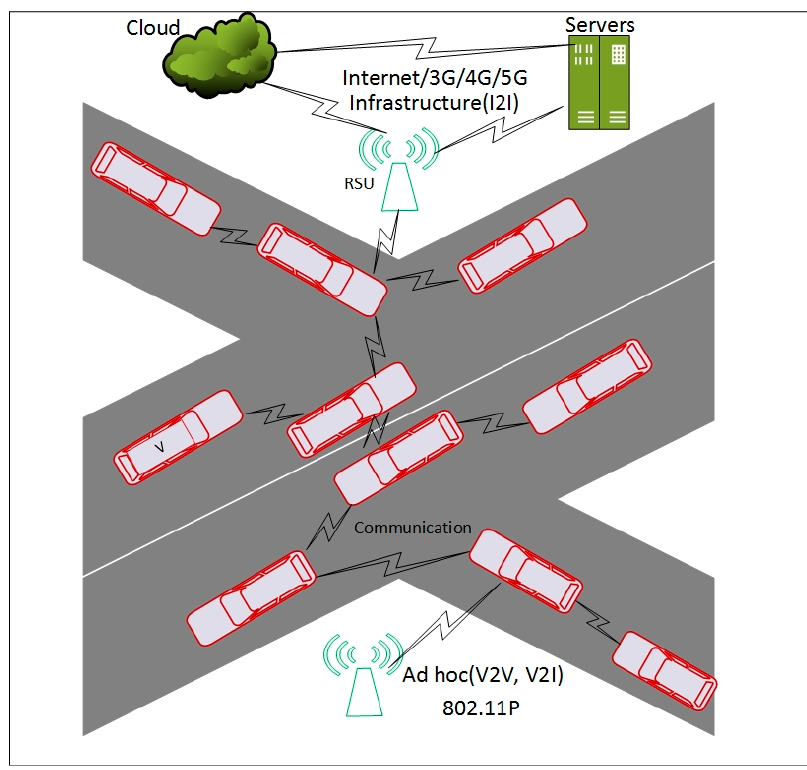
Figure 3. Intelligent transport system dissemination formation.